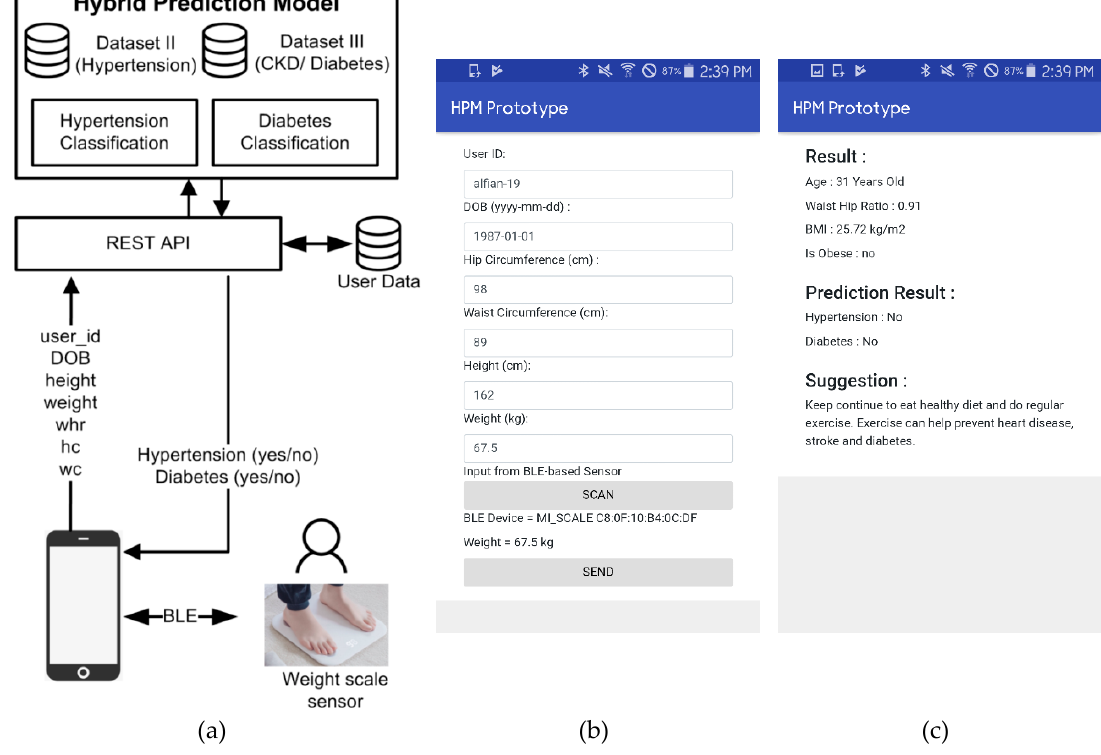
Figure 5. Internet of Things (IoT)-based Health-care Monitoring System ( a ); input of risk factors ( b ), and the proposed HPM model predicts the presence of hypertension as well as diabetes ( c ).